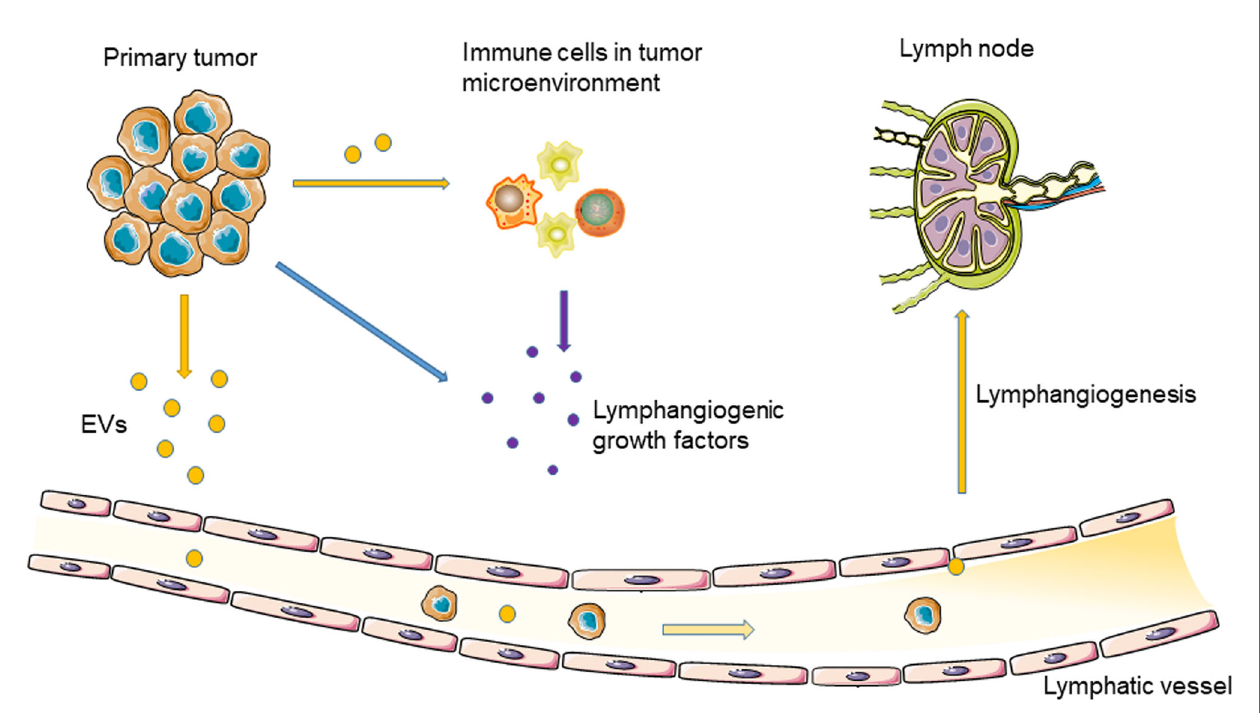
FIGURE 1 | Tumor-derived EVs regulate tumor lymphangiogenesis and lymphatic metastasis through delivering nucleic acids and